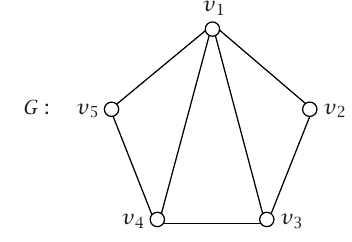
Figure 3.1 . Illustrating resolving